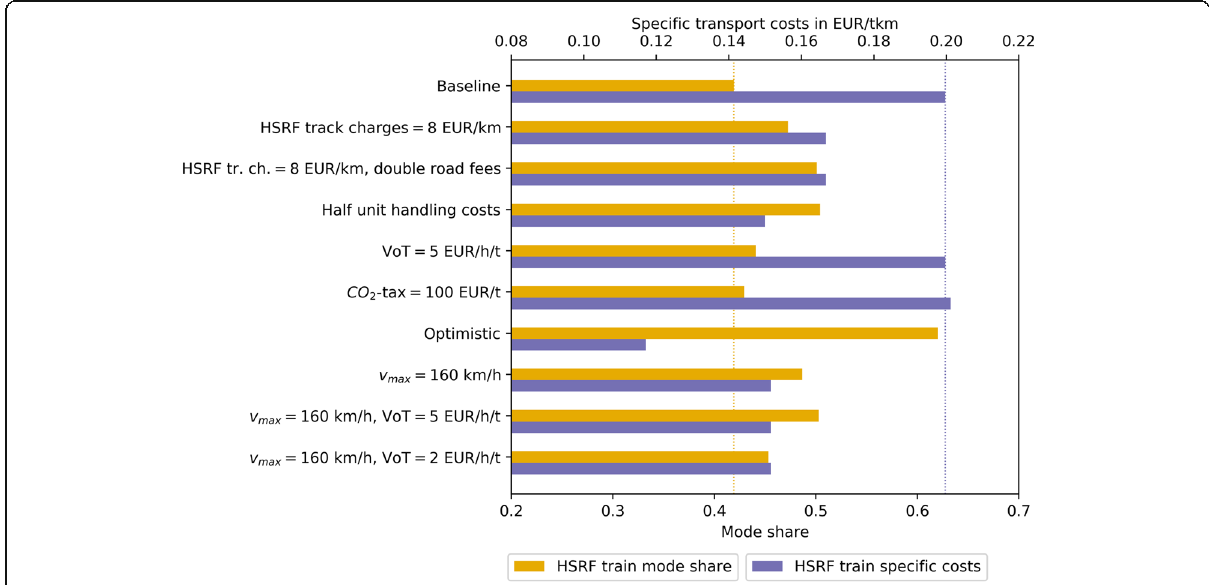
Fig. 4 Sensitivity of mode share and specific costs for the HSRF concept to distinct parameter